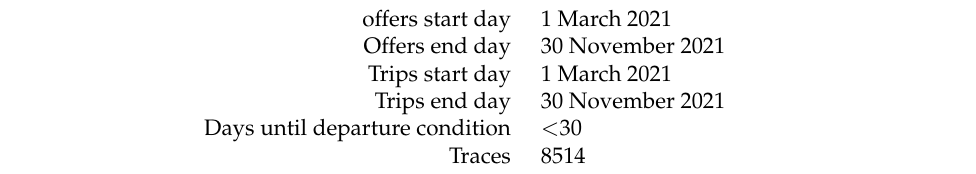
Table 7. Event Log settings.